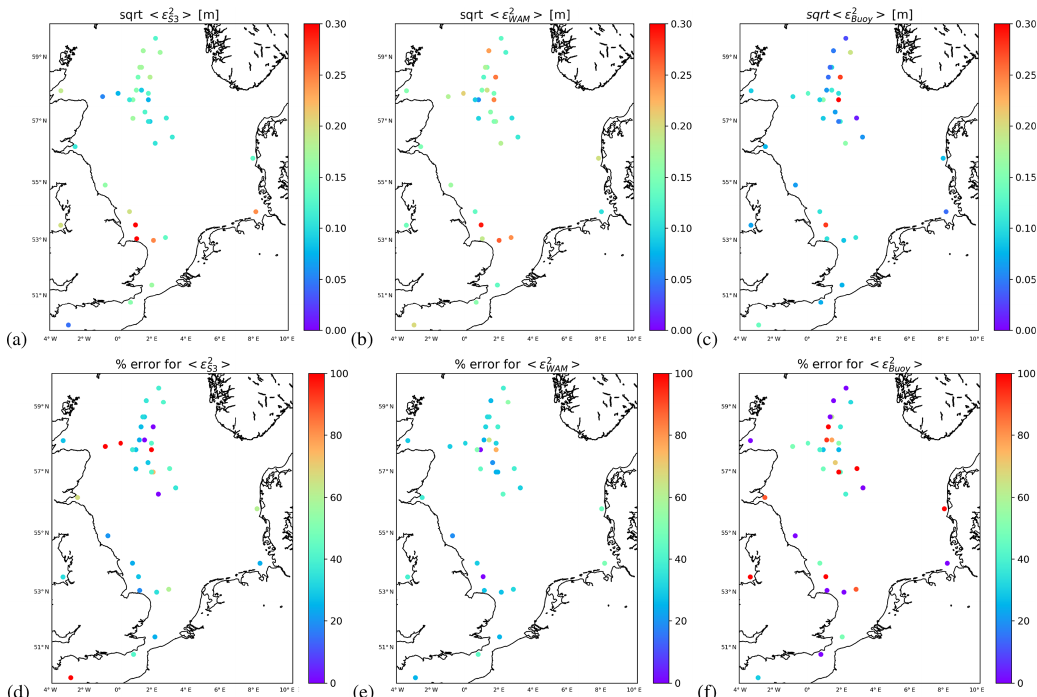
Figure 7. (a, b, c) Colour coded stochastic error standard deviations of wave heights provided by the Sentinel-3A altimeter (a) , the WAM model (b) , and the in situ stations (c) estimated by triple collocation . (d, e, f) Relative uncertainties in the stochastic error estimates derived by using the approach in Sect.